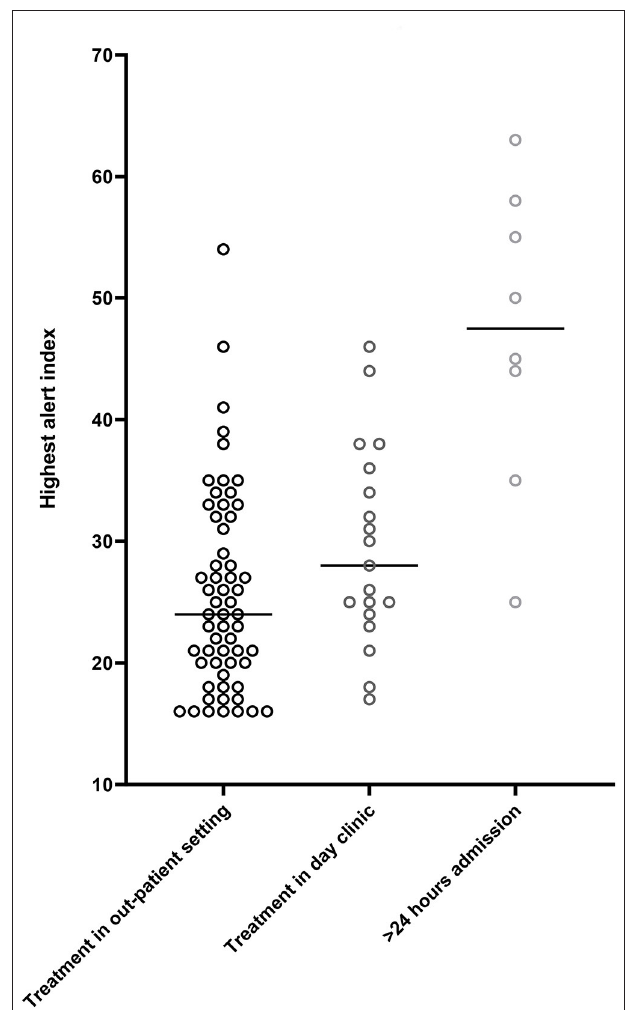
FIGURE 4 | Median highest HeartLogic TM index (from surpassing the alert threshold until below the recovery threshold). Alert height in patients receiving care in the outpatient setting, median 25 [IQR 20–31]. Alert height in patients receiving treatment in the day clinic, median 28 [IQR 24–36]. Alert height of patients receiving > 24h in hospital care, median 45 [IQR